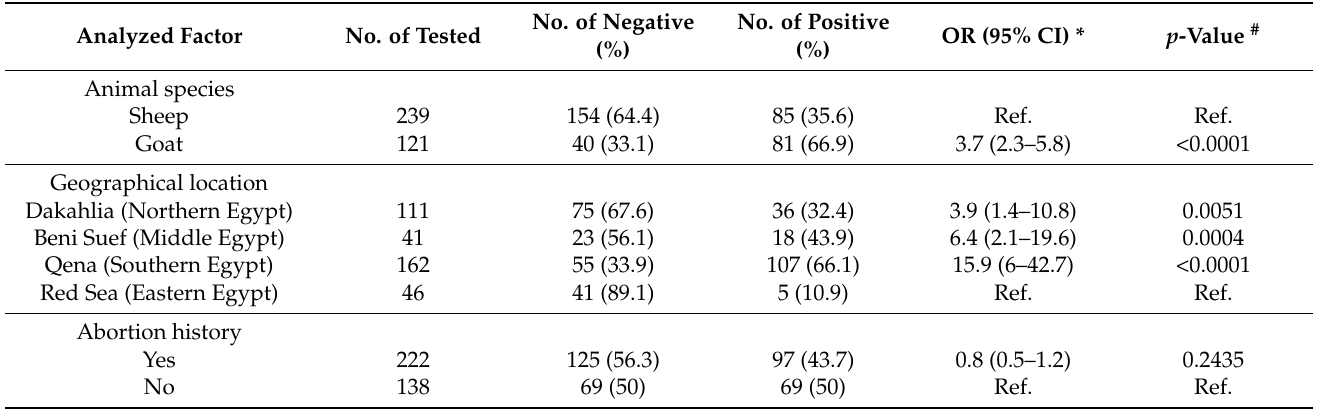
Table 4. Risk factors for T. gondii antibodies in sheep and goats in